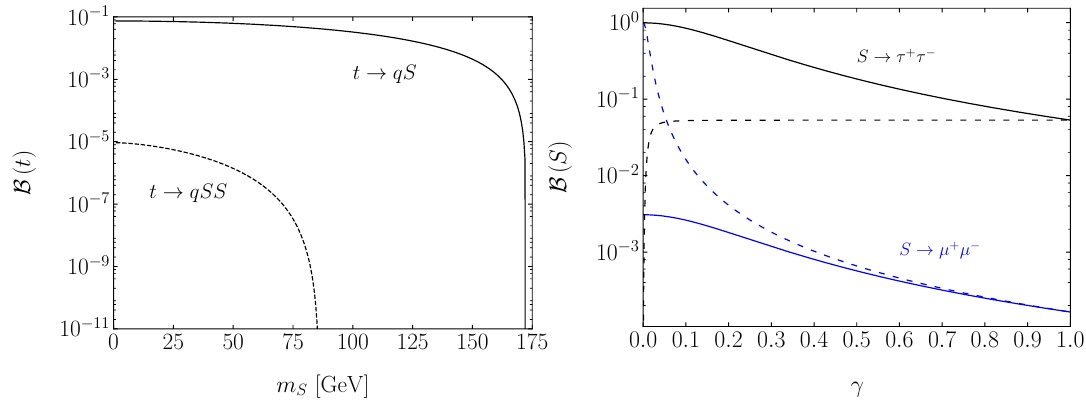
Figure 1 . Left) Top branching ratios as a function of the mass of S , for e Y q Y q 3 i = 1 and (cid:3) = 1 TeV. Right) Scalar branching ratios into muons (blue) and taus (black), as a function of the Z 2 breaking parameter, (cid:13) , for m S = 100 GeV. We represent two cases: (in solid lines) (cid:13) ‘ = (cid:13) (cid:28) = 1 while (cid:13) q = (cid:13) ; and (in dashed lines) (cid:13) ‘ = 1 and (cid:13) (cid:28) = (cid:13) q = (cid:13)